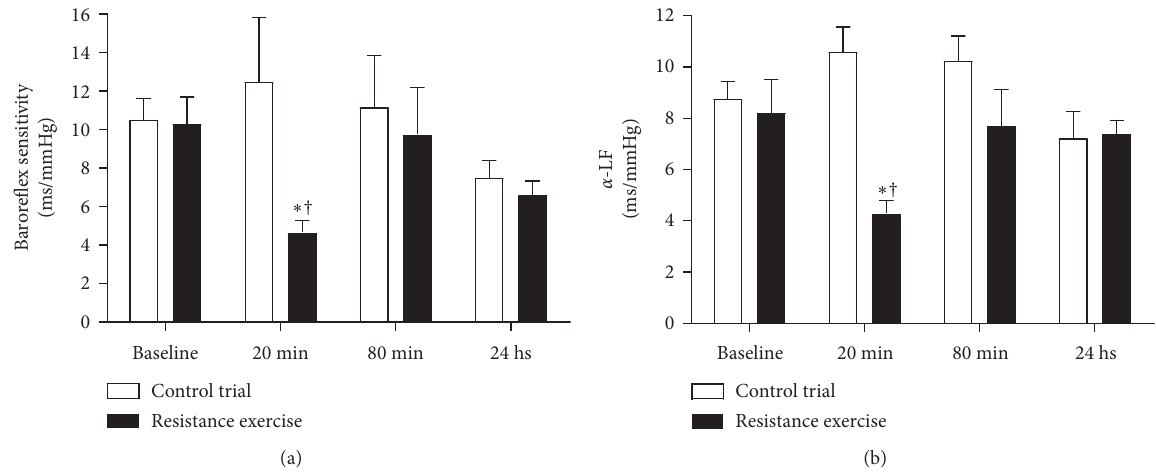
Figure 4: Baroreflex sensitivity index (a) and α -LF (b) assessed before and after RE and CTR trial. ∗ p < 0 . 05 versus baseline; † p < 0 . 05 versus same moment of CTR